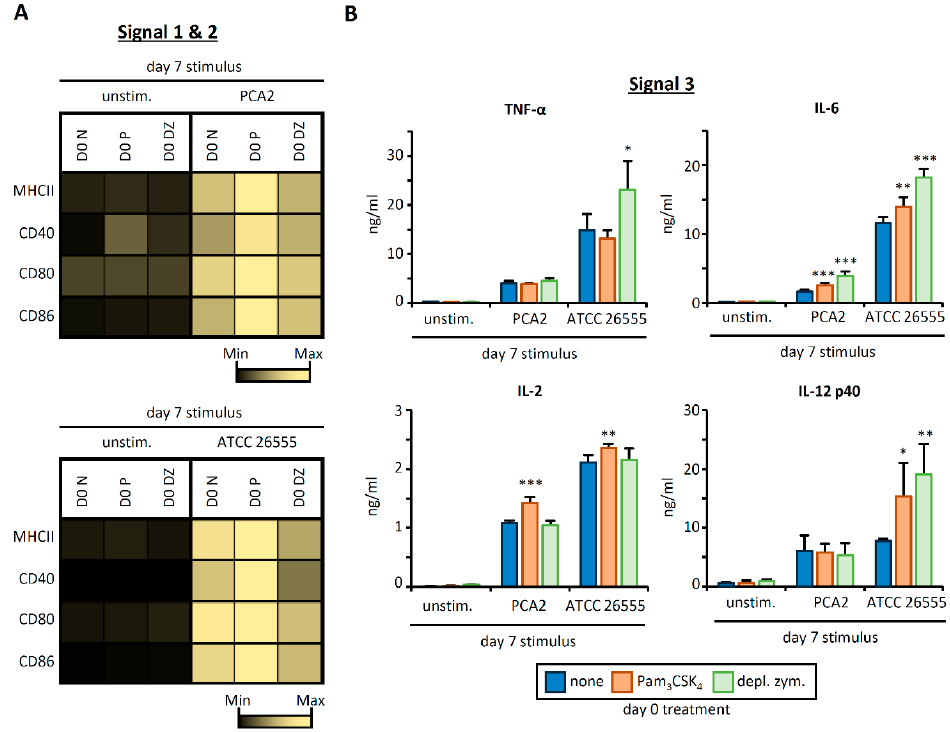
Figure 3. Pam 3 CSK 4 - or depleted zymosan-stimulated HSPCs generate APCs with an